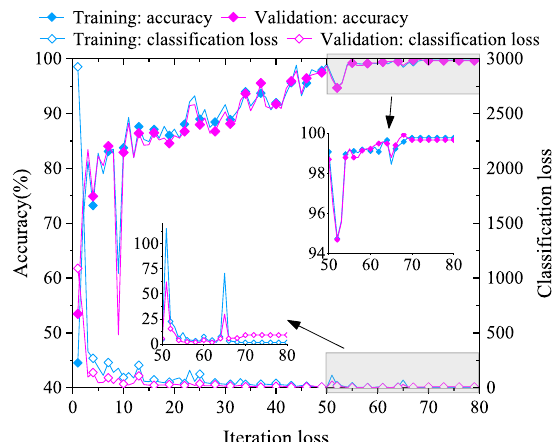
Fig. 12 Training and validation results of